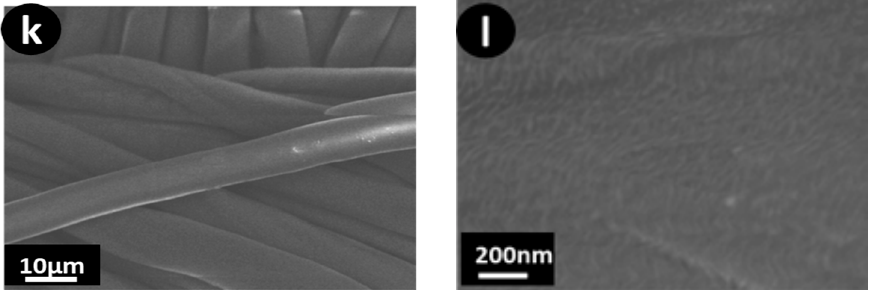
Figure 2. Field emission scanning electron microscope (FESEM) images of the samples at different magnifications. ( a , b ) F1, ( c , d ) F2, ( e , f ) F3, ( g , h ) F4, ( i , j ) F5, and ( k , l ) uncoated.